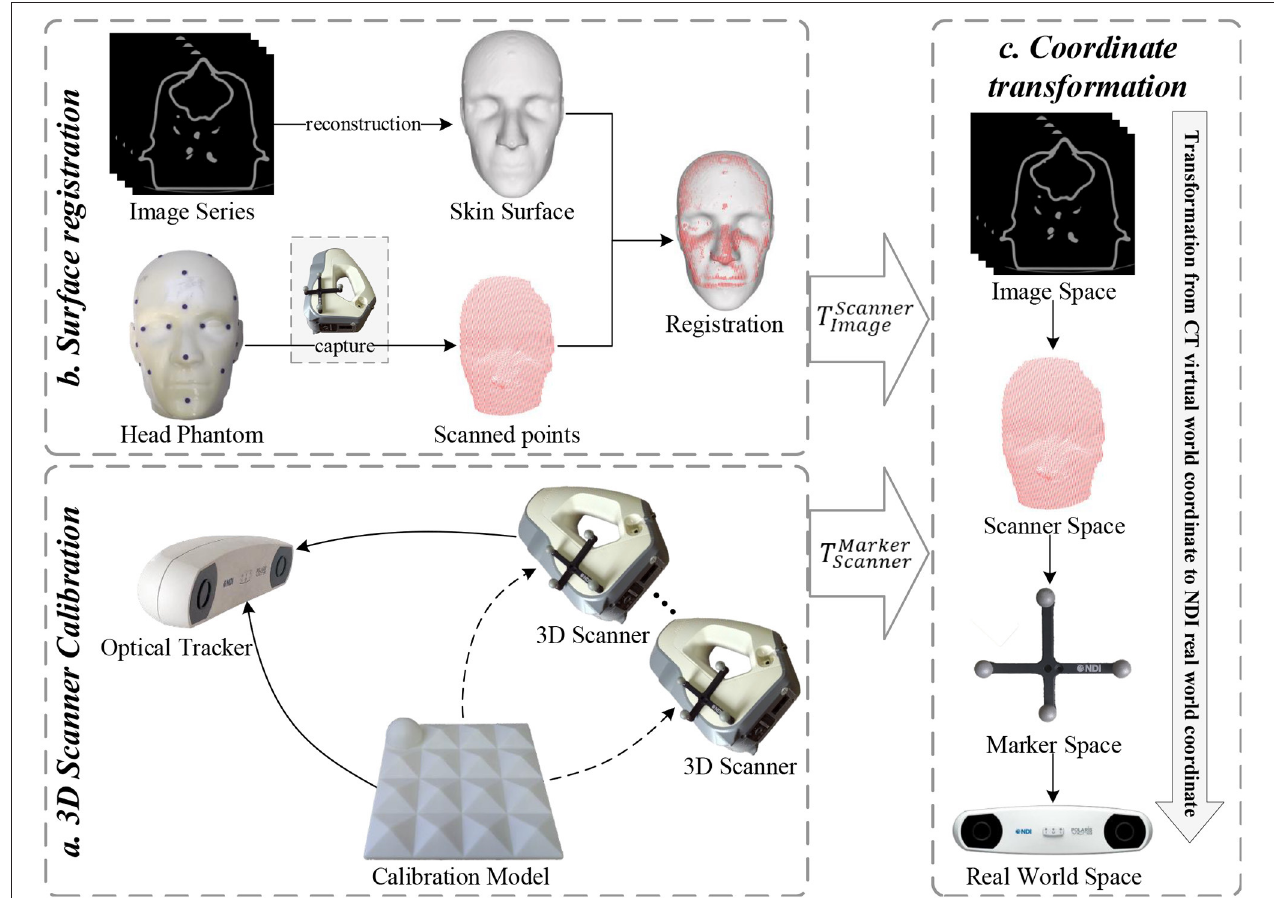
FIGURE 5 | Flowchart of the proposed 3D scanner-based image-to-patient registration